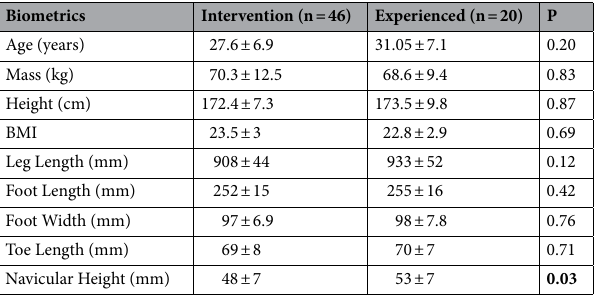
Table 2. Biometric and statistical comparisons between the study groups. Significance level is set at P < 0.05.